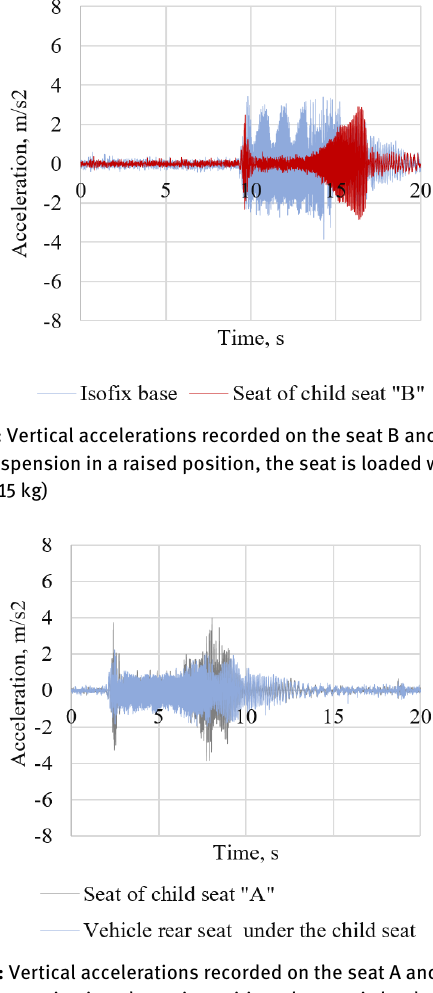
Figure 11: Vertical accelerations recorded on the seat A and ISOfix base (suspension in a raised position, the seat is loaded with